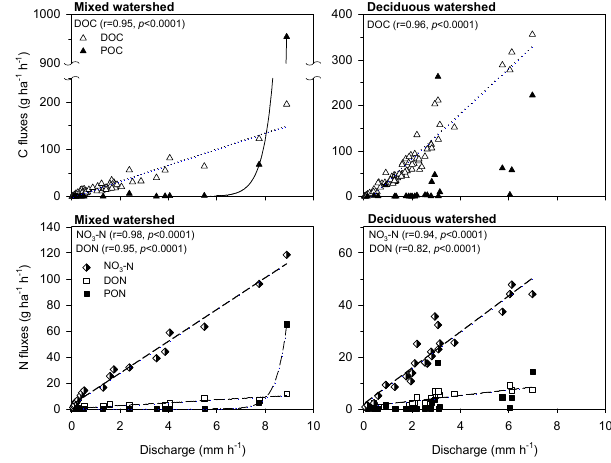
Figure 4. Fluxes of carbon (dissolved organic carbon (DOC) and particulate organic carbon (POC)) and nitrogen (dissolved organic nitrogen (DON), particulate organic nitrogen (PON), and nitrate (NO 3 –N)) in runoff with discharge during monsoon storm